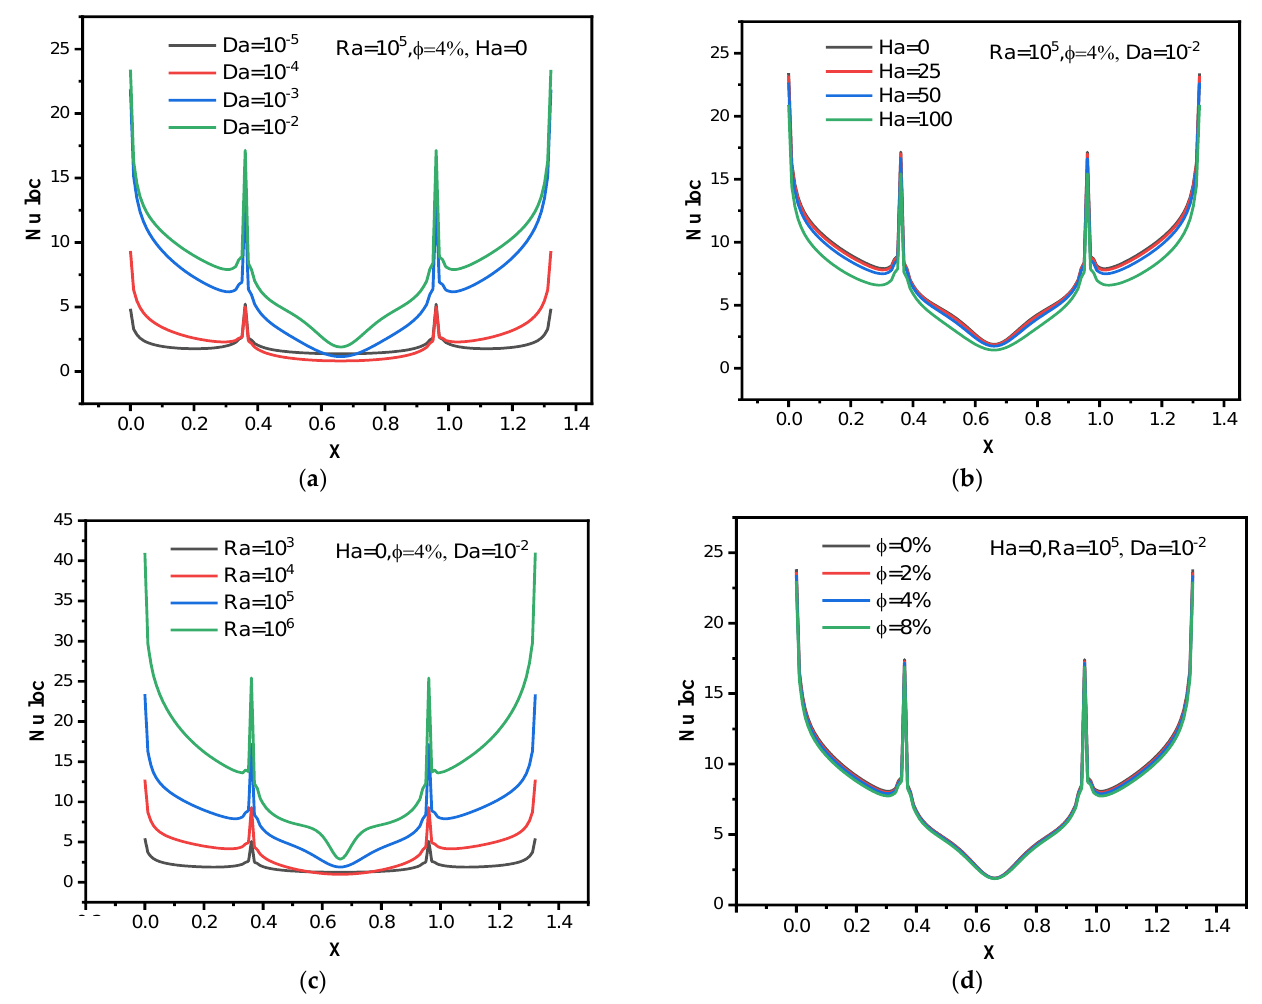
Figure 7. Effects of ( a ) Da number, ( b ) Ha number, ( c ) Ra number and ( d ) nanoparticle volume fraction on the local Nusselt number.